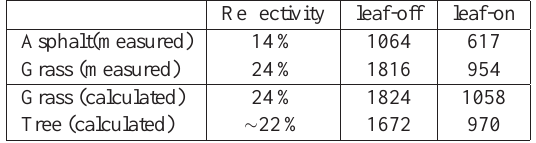
Table 2: Relative reflectivity, estimated mean values for both data sets and derived reference values rv mean .